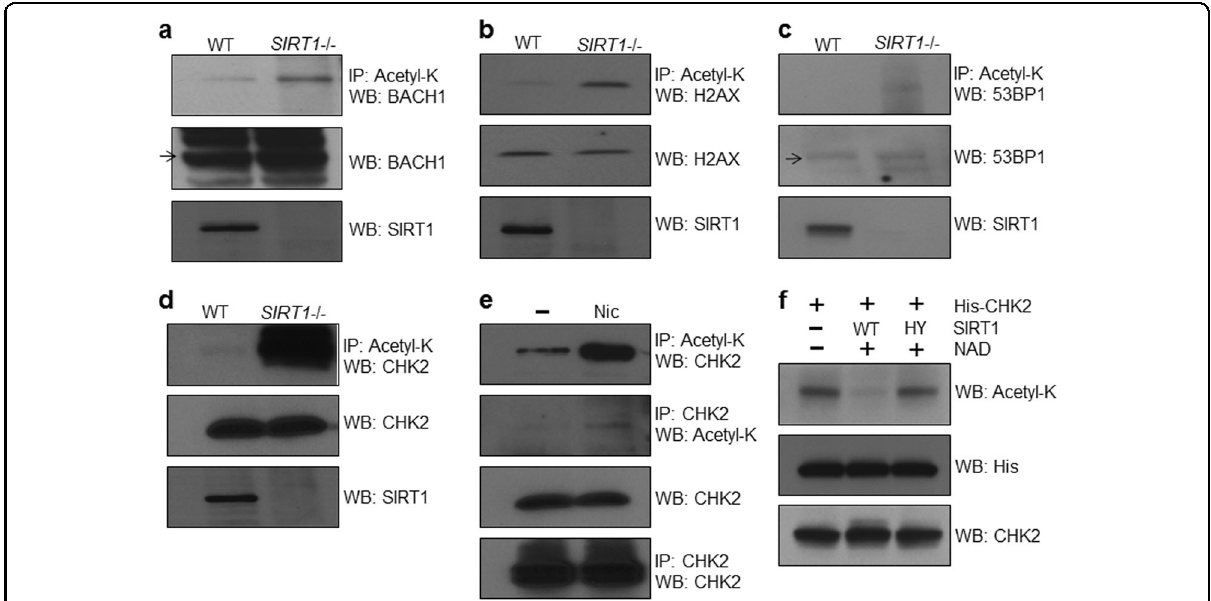
Fig. 1 SIRT1 regulates the acetylation status of the molecular complexes in response to DNA damage. a – c The acetylation levels of BRCA1/ BRCA2-associated helicase 1 (BACH1), H2AX, and tumor suppressor p53-binding protein 1 (53BP1) were increased in SIRT1 knockout (KO) mouse embryonic fi broblasts (MEFs). d The acetylation level of CHK2 (Checkpoint Kinase 2) was highly elevated in the SIRT1 -de fi cient cells. e Treatment with nicotinamide (Nic) increased the acetylation level of CHK2 in HeLa cells. f Puri fi ed CHK2 in HeLa cells was deacetylated by puri fi ed SIRT1 WT but not